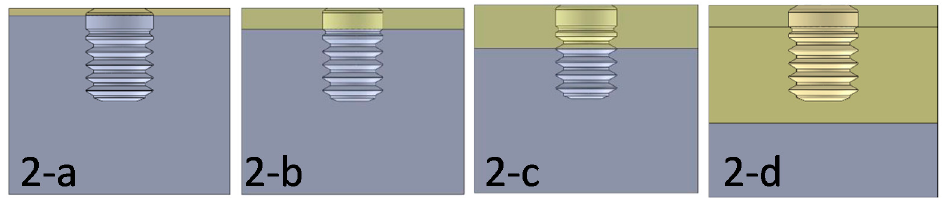
Figure 1. ( 1-a ). 3D model with an Ø3.3 implant in axial position and Type III bone. ( 1-b ). 3D model with an Ø3.5 implant in axial position and Type III bone. ( 1-c ). 3D model with an Ø3.75 implant in axial position and Type III bone. ( 1-d ). 3D model with Ø4 implant in axial position and Type III bone. ( 1-e ). 3D model with an Ø4.25 implant in axial position and Type III bone. ( 1-f ). 3D model with Ø4.75 implant in axial position and Type III bone.